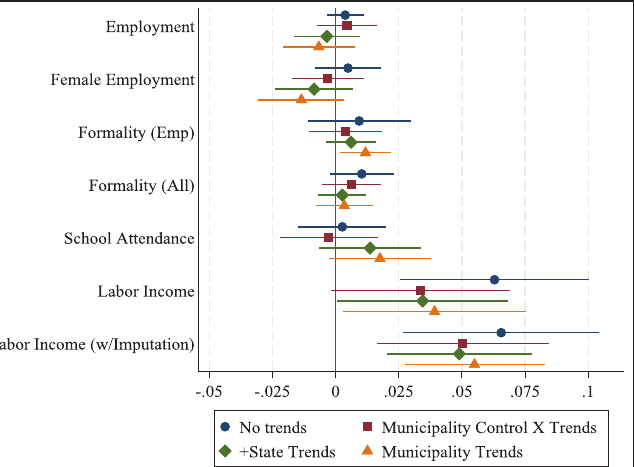
Labor force survey results using repeated cross-sections, 2015–2019.